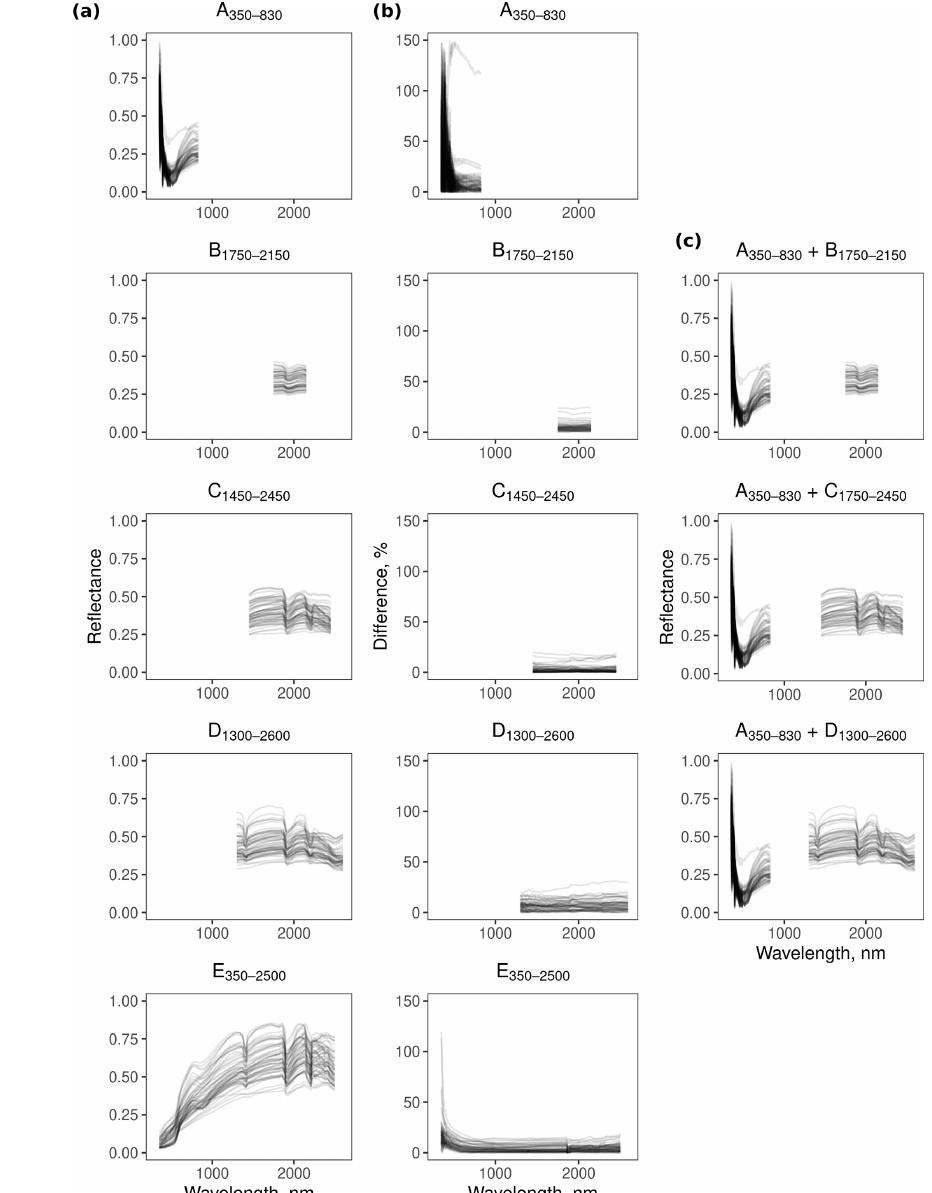
Figure 3. Mean and difference spectra of the spectral replicates of the data from the 56 sampling plots. (a) Average reflectance spectra of the two replicates (Fig. 2). (b) Difference between the two replicates calculated using Eq. (1). (c) Combined average reflectance spectra from (a) .